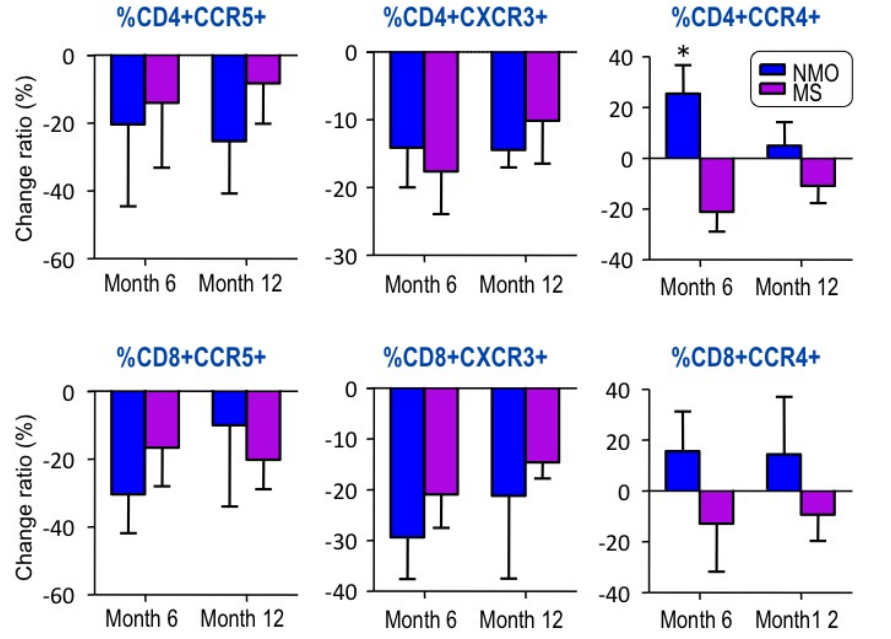
Figure 1. Changes in expression of CCR4, CCR5 and CXCR3 on CD4+ and CD8+ T cells between samples obtained from patients with NMO (blue) and MS (purple) at baseline and after 6 or 12 months of IFN-â1b